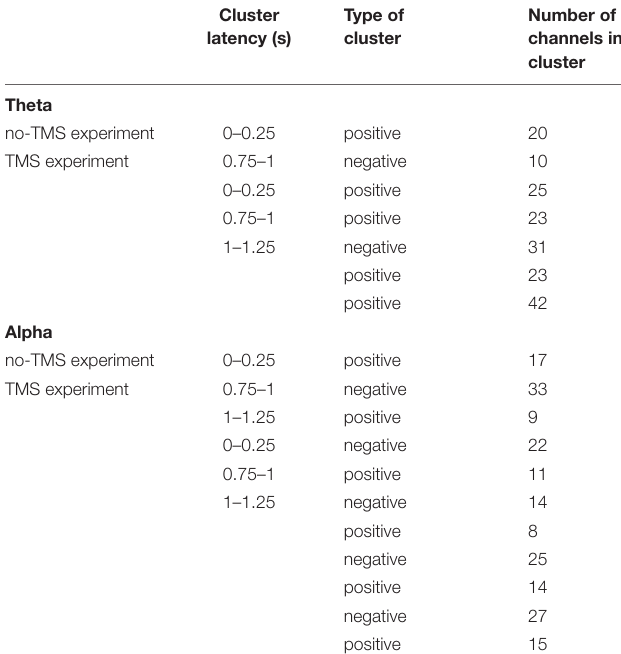
TABLE 2 | Significant clusters ( p < 0.05) between conditions (CS + and CS − ) that were compared regarding weighted phase lag index (WPLI) in theta and alpha frequency bands using cluster-based